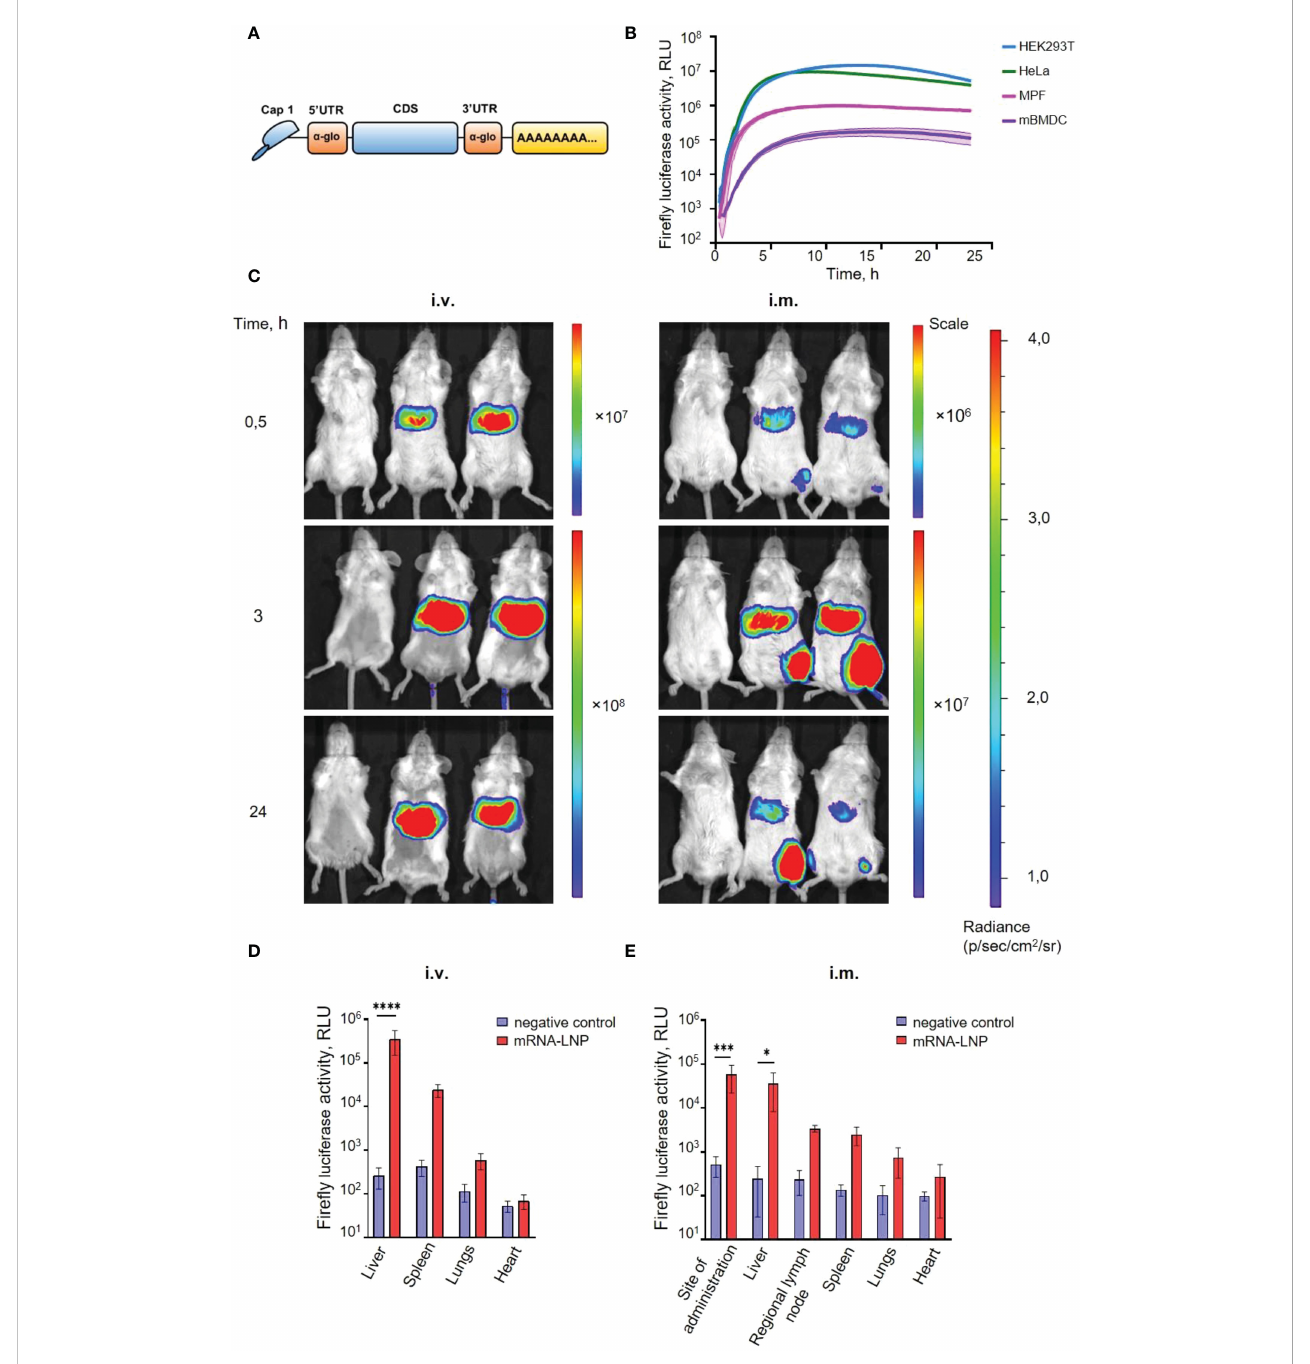
FIGURE 1 An mRNA platform design and characterization. (A) Schematic representation of the mRNA platform used in this study. (B) Fire fl y luciferase expression continuously measured after mRNA transfection of cultured mammalian cells: two human cell lines (HEK293T and HeLa), mouse primary fi broblasts (MPF), and mouse bone marrow-derived dendritic cells (mBMDC). Luciferase activity curves represent the mean (lines) and SD (shaded regions) of three technical replicates. (C) Luciferase activity in mice detected with in vivo imaging system (IVIS). BALB/c mice were injected with 5.0 µg mRNA-LNP in PBS (right and middle mouse), or PBS (left mouse) by intramuscular (i.m.) and intravenous (i.v.) routes. Relative luminescence plot is shown, and the scale of luminescence is indicated. (D, E) Luciferase activity in homogenates of different organs after 3 h after intramuscular (i.m.) or intravenous (i.v.) administration of mRNA-LNP preparation. Boxes and whiskers represent means with standard deviations (SD). p -value determined by Bonferroni ’ s multiple comparisons test. *p < 0.05, ***p < 0.001, ****p <